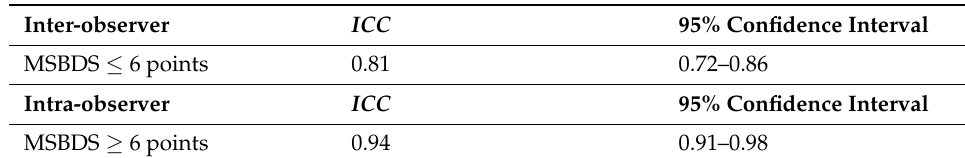
Table 3. Global inter- and intra-observer agreement among the 15 readers considering the MSBDS with scores below or equal to 6 points and scores above 6 points. K values are reported as weighed with linear weights.